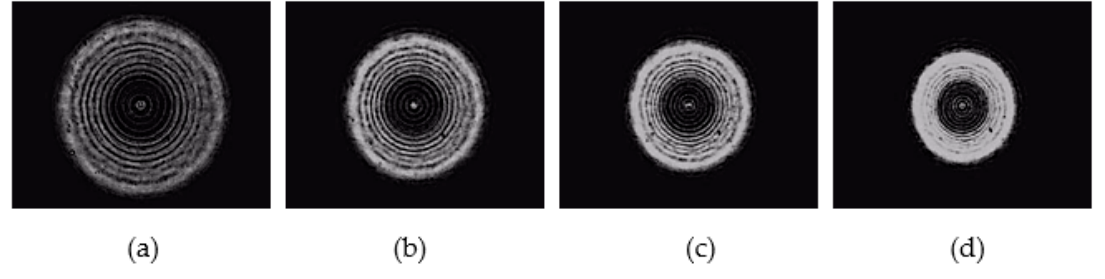
Figure 9. The principle of the annular beams focused by a lens. Table 2. Radii of the annular beam of theory and generated by the SLM.